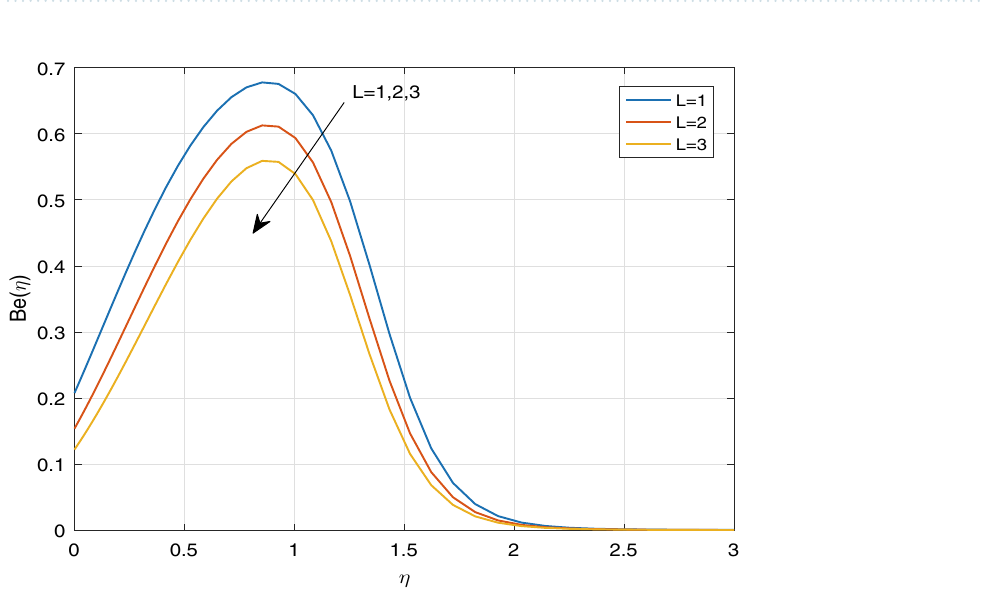
Figure 20. Sketch of Be against L